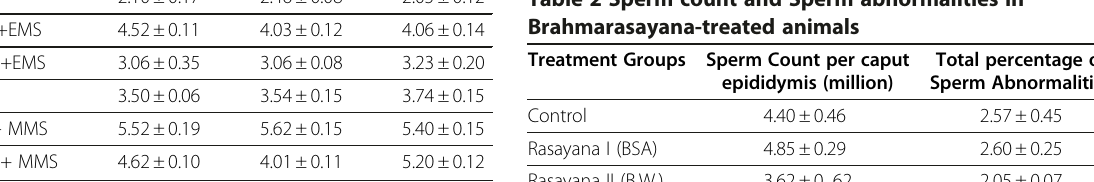
level in Rasayana 1 and EMS-treated animals when com- pared to the controls. The groups receiving BR and EMS combination treatments showed maximum SOD activity when compared to all other treated groups of animals suggesting antioxidant activity of BR (Table 3). Catalase activities were reduced in combined treatment of BR Table 2 Sperm count and Sperm abnormalities